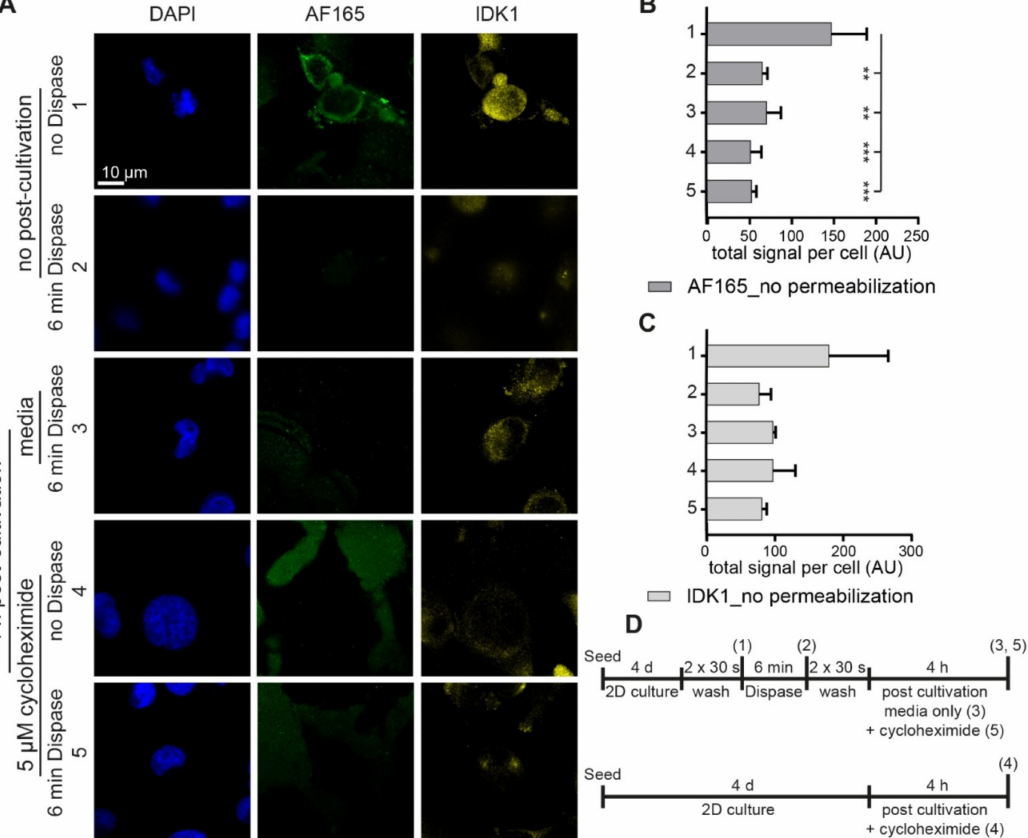
Figure 3. In the absence of permeabilization, BSP immunofluorescence levels are diminished upon dispase exposure. 1,200,000 MDA-MB-231 cells were seeded in Petri dishes containing glass cover slips. After 4 d, cultures were treated with dispase and partially further cultivated with media or for secondary treatments with cycloheximide after washing, as indicated. PFA fixed and non-permeabilized samples were stained for DAPI and human BSP (AF165 and IDK1). ( A ) Representative confocal images in sum projections. ( B , C ) Graphs showing quantitative analysis of fluorescence intensity per cell. See ( D ) for methodology. Mean + SD ( n = 3; ** p < 0.01, *** p <